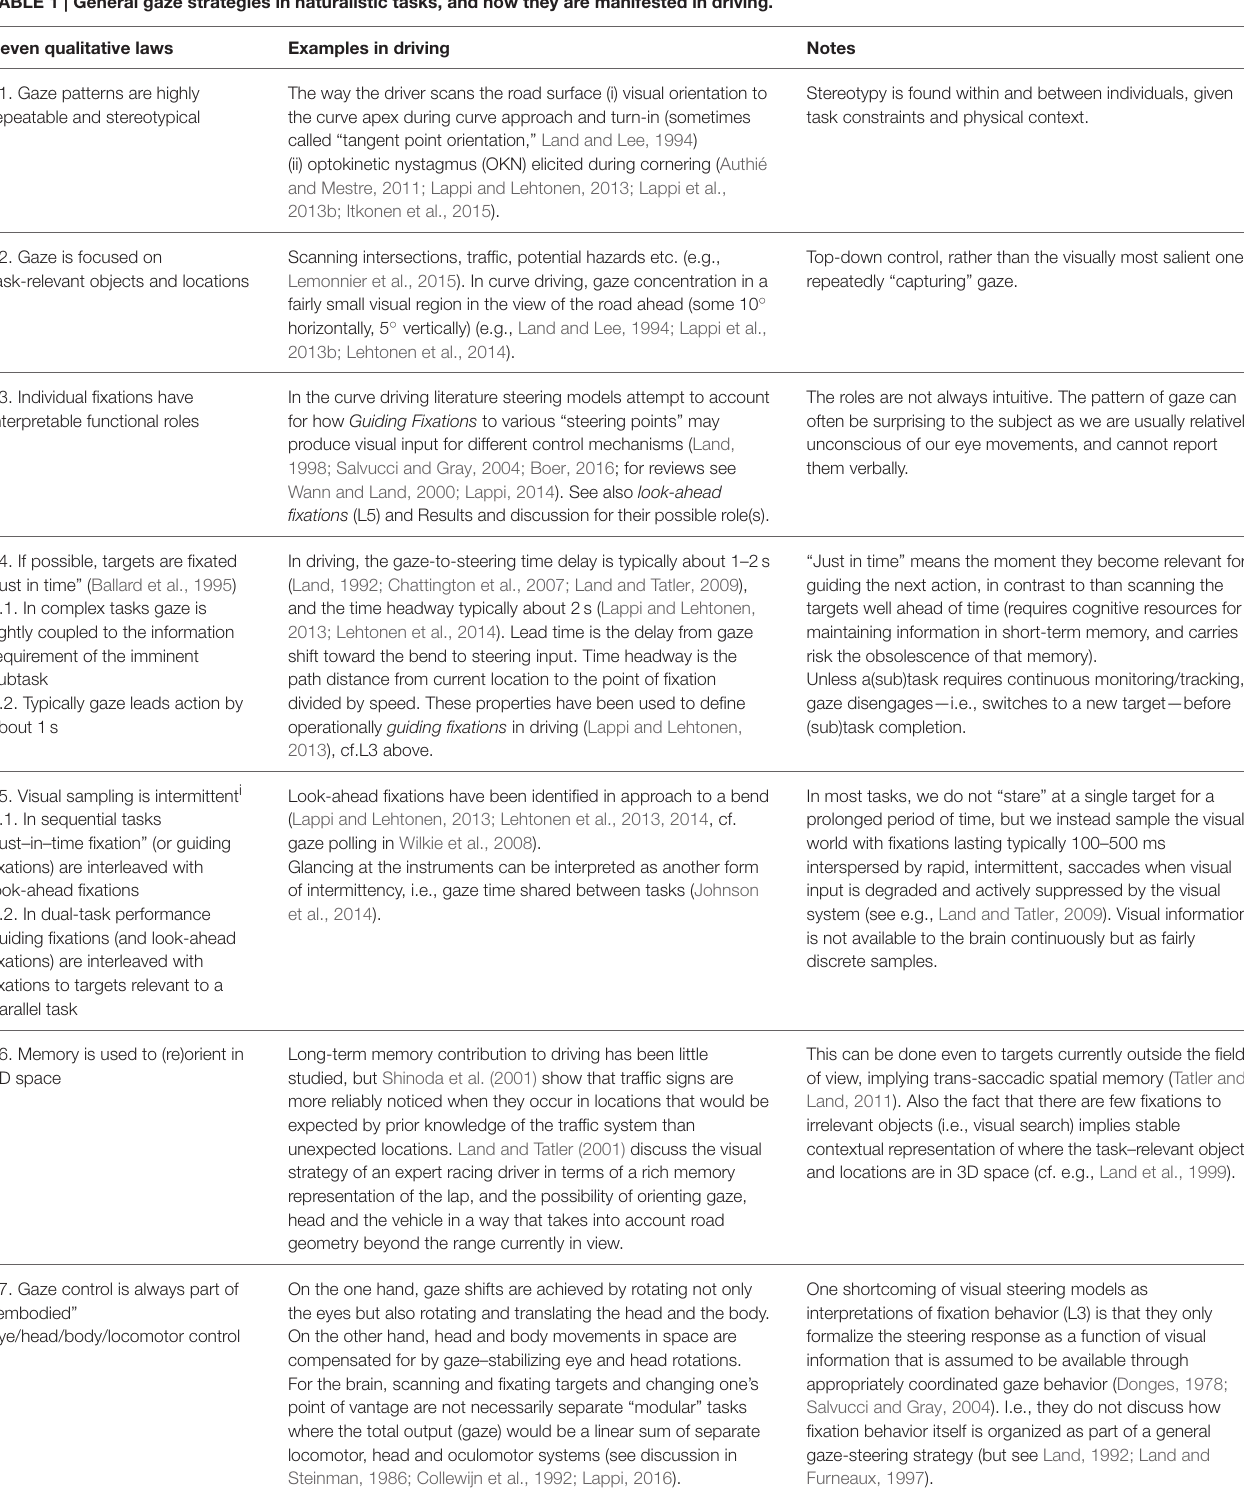
TABLE 1 | General gaze strategies in naturalistic tasks, and how they are manifested in